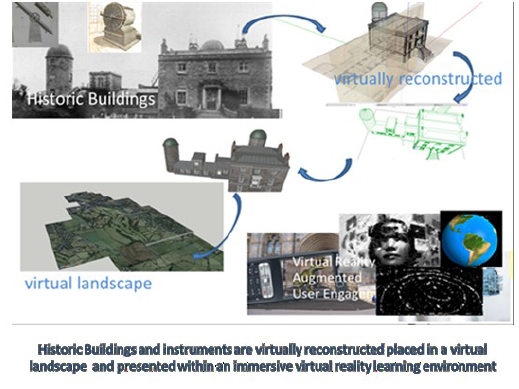
Figure 13: Virtual Reconstruction of